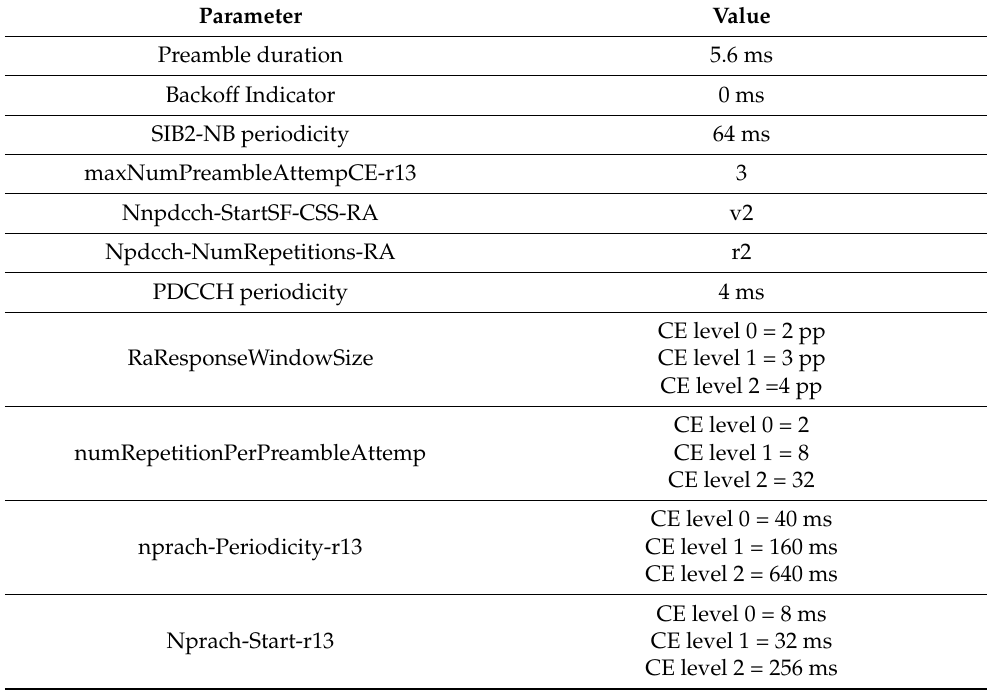
Table 4. NB-IoT simulation parameters.